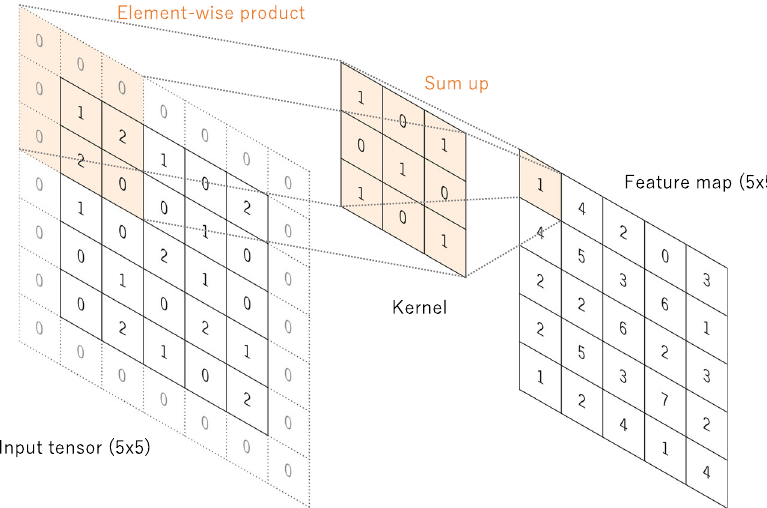
Fig. 4 A convolution operation